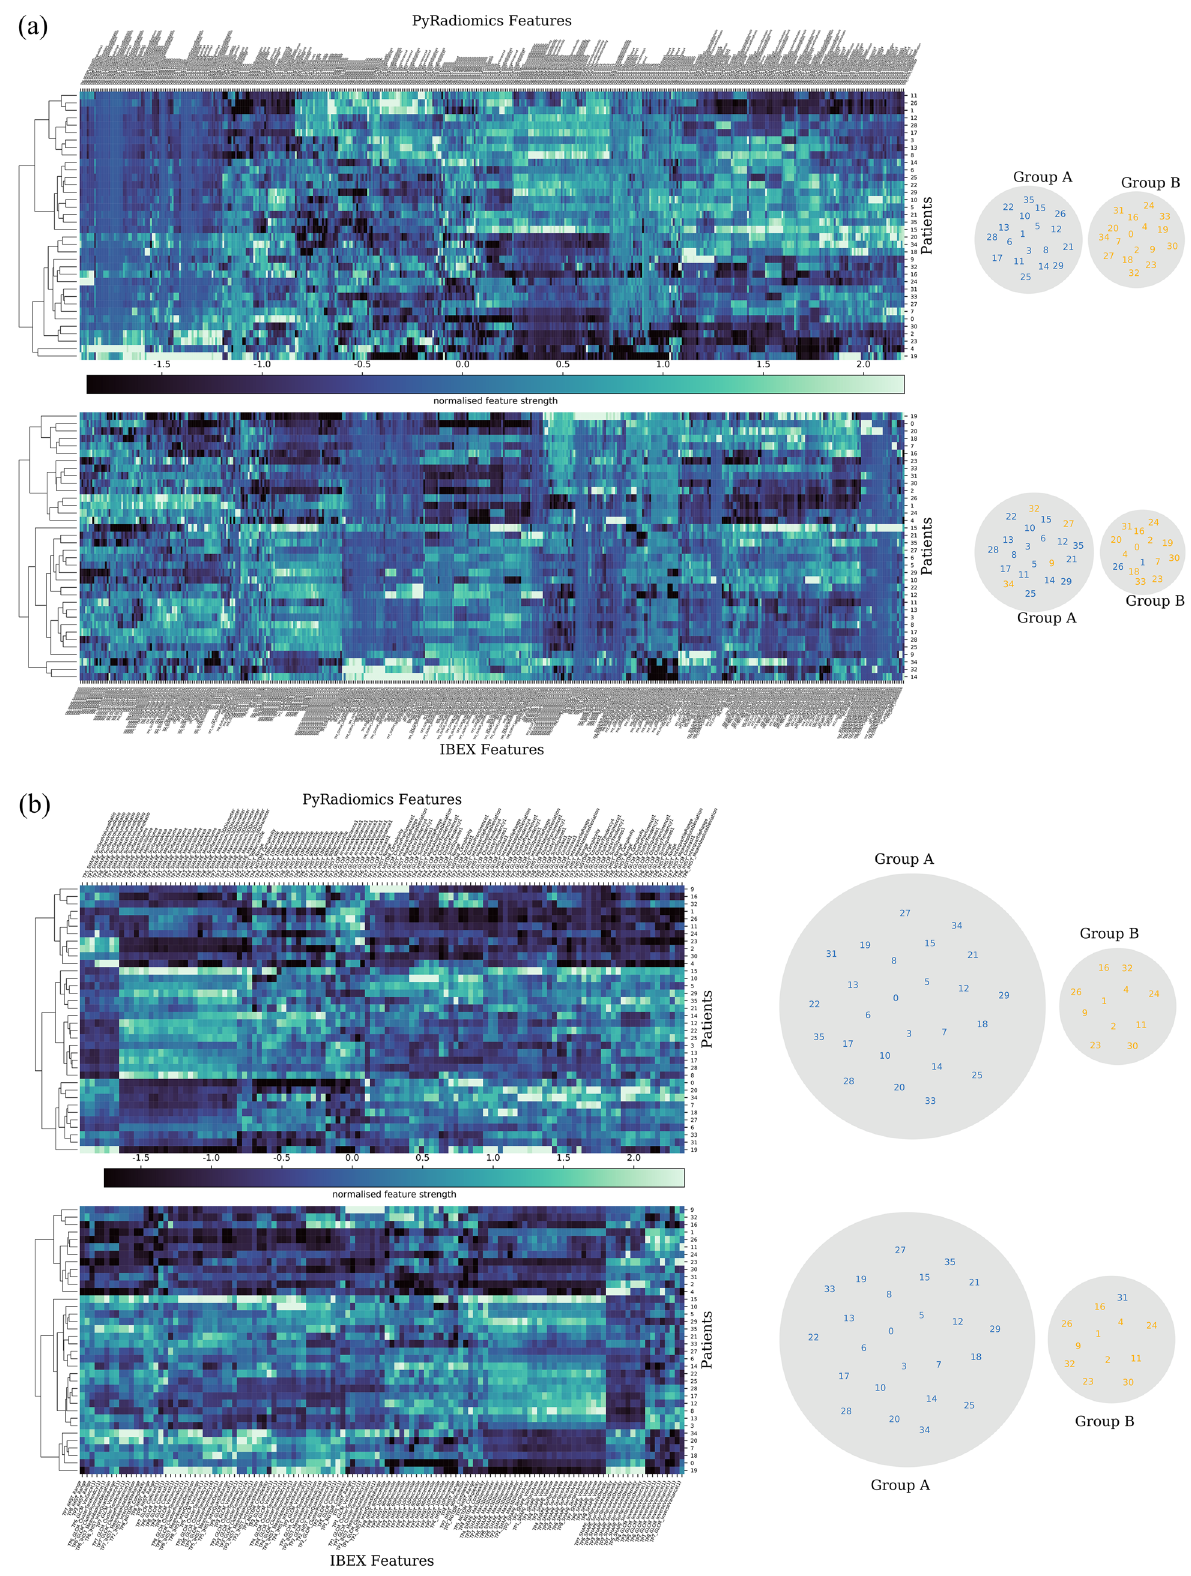
Figure 4. Comparison of hierarchical clustering of patients with PyRadiomics and IBEX using ( a ) all shared features and ( b ) a sub-set of reproducible features ( r > 0.901 ). Unsupervised hierarchical clustering generates a (left) radiomic signature of change in apparent diffusion coefficient (ADC) features after one fraction of radiotherapy in 36 head and neck cancer patients and (right) the resulting patient groups. Clustering with ( a ) non-reproducible features creates a difference in the patient groups generated from PyRadiomics or IBEX features. Clustering with ( b ) a sub-set of reproducible features leads to almost identical patient groups generated from PyRadiomics or IBEX